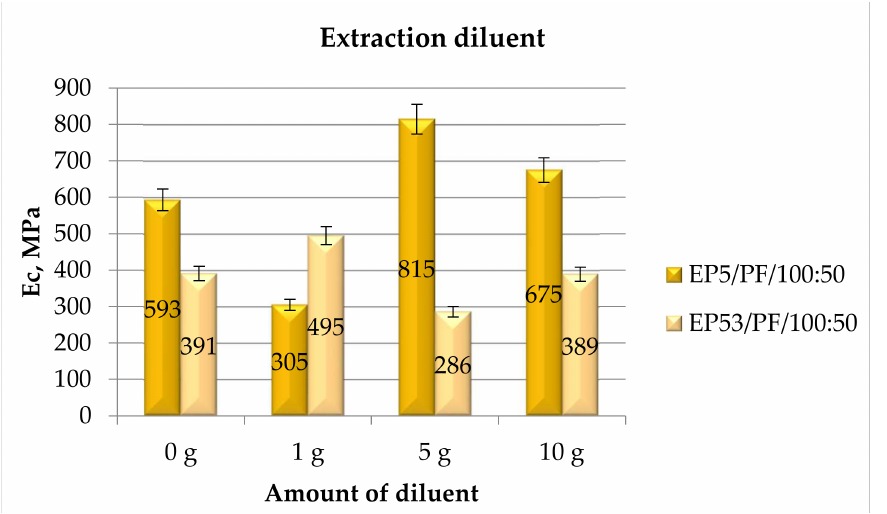
Figure 9. Compressive modulus calculated for Epidian 5 and Epidian 53 epoxy compounds as a function of the amount of extraction